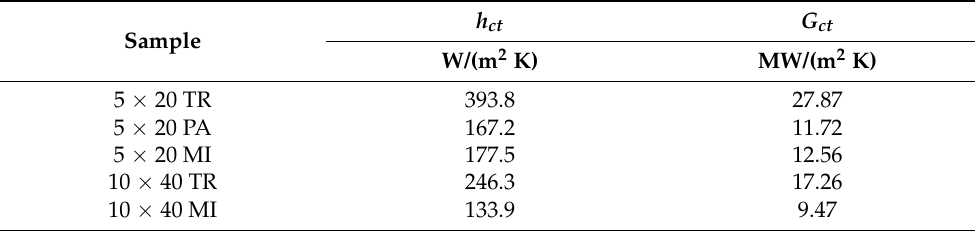
Table 8. The values of G ct parameter obtained for individual samples for the temperature of 20 ◦ C.